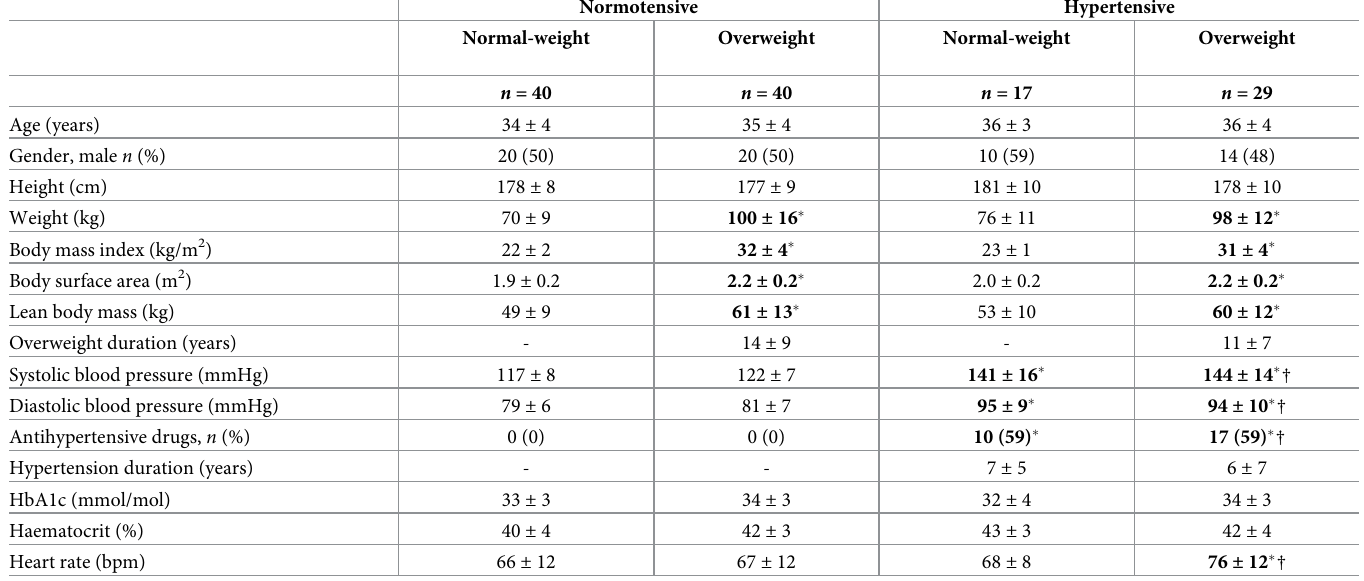
Table 1. Study population characteristics.